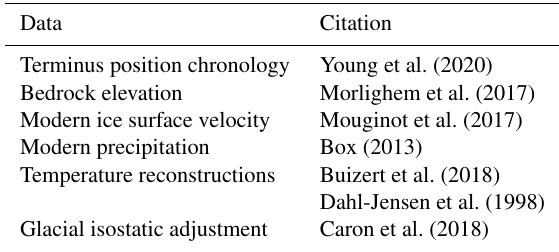
Table 2. Citations for the primary data sets used in this